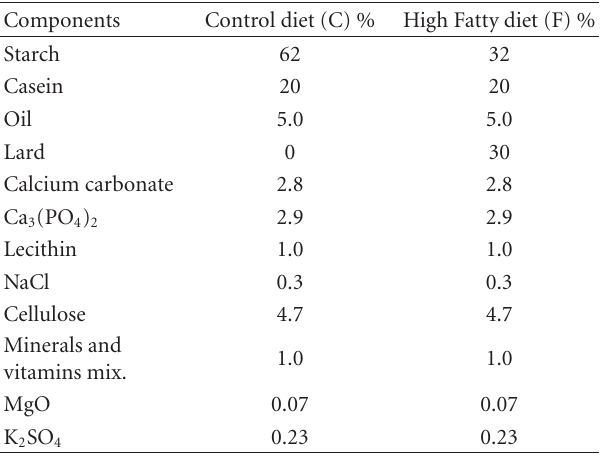
Table 1: The composition of the control diet (C) and high fat diet (F) administered to Wistar